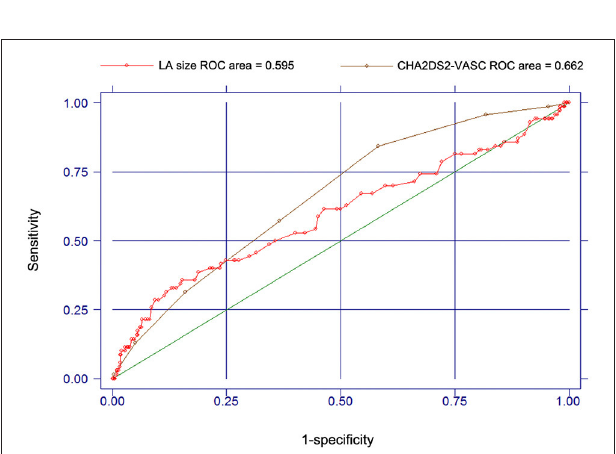
FIGURE 3 | Receiver operating characteristic curves and c-statistics for CHA 2 DS 2 -VASC score and LA size in predicting the occurrence of stroke or TIA.